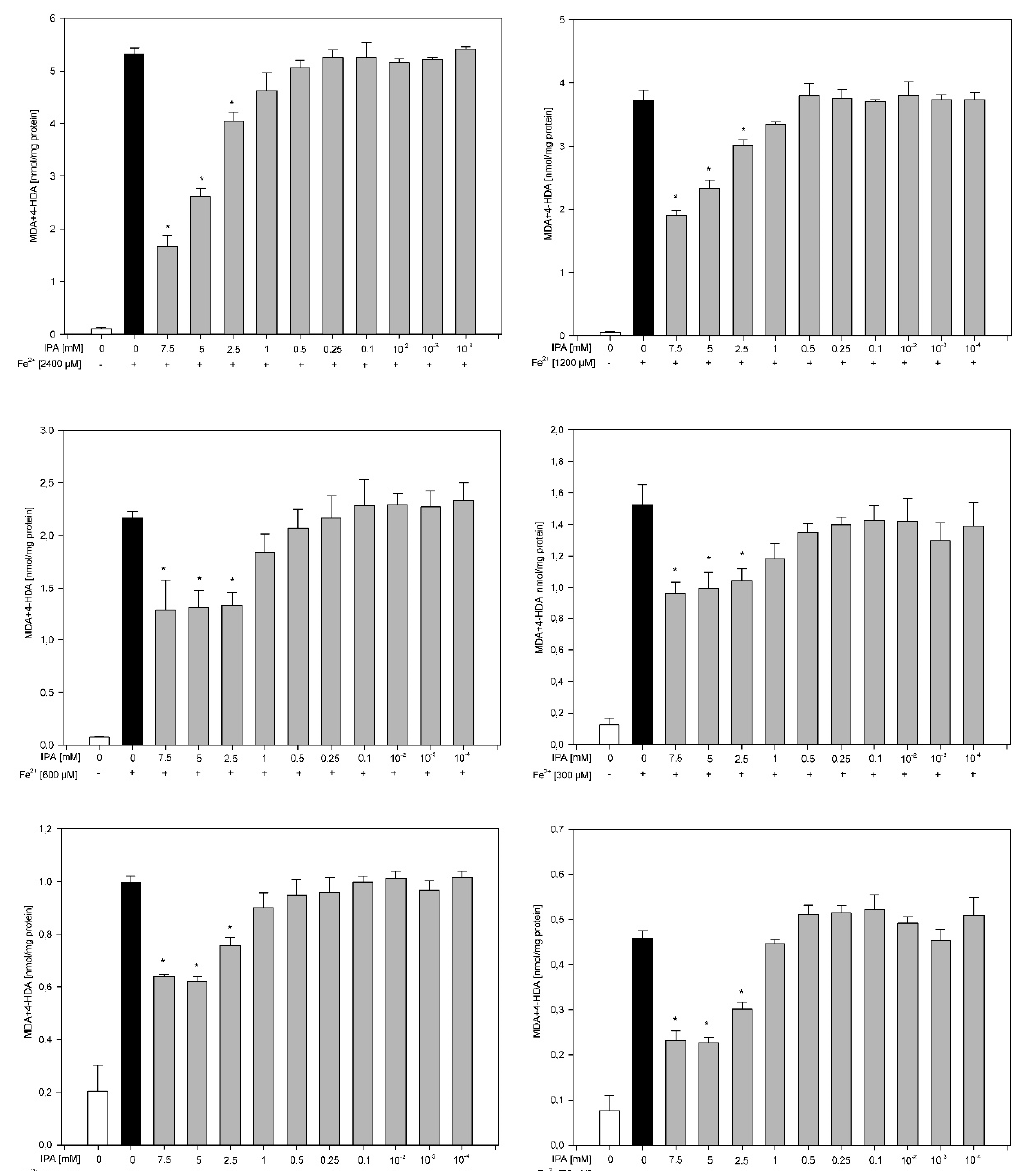
Figure 3. Concentration of malondialdehyde + 4-hydroxyalkenals (MDA + 4-HDA) in skin homogenates. Homogenates were incubated in the presence of FeSO 4 used in one of six different concentrations (2400, 120, 600, 300, 150 and 75 µM) plus H 2 O 2 (5 mM) and, additionally, in the presence of IPA (0.0, 7.0, 5.0, 2.5, 1.0, 0.5, 0.25, 0.1, 0.01, 0.001 and 0.0001 mM). Data are expressed as the amount of MDA + 4-HDA (nmol) per mg of protein. Bars represent the mean ± SE of three independent experiments run in duplicate. * p < 0.05 vs. the respective concentration of Fe 2+ (black bars). All bars representing either Fe 2+ (black bars) or Fe 2+ plus IPA (gray bars) are significantly higher than bars representing control (white bars).